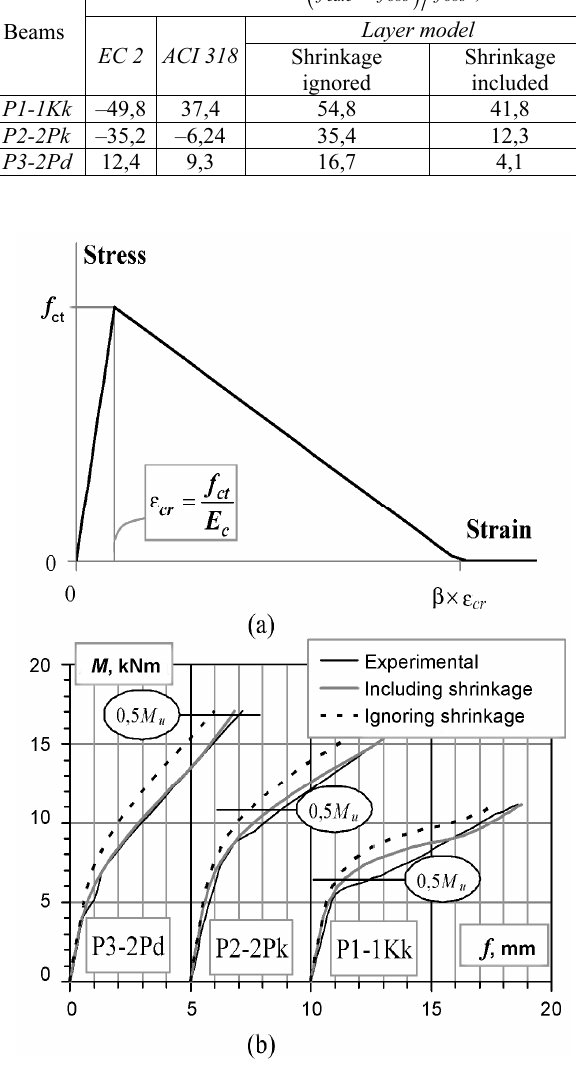
Table 9. Relative error of deflection predictions at service load- ing ( Relative error